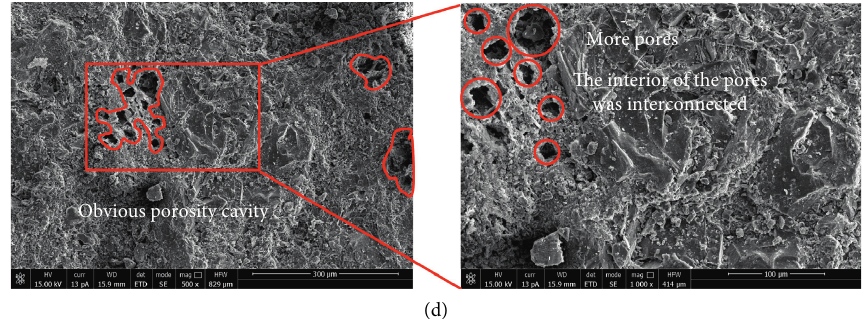
Figure 17: Evolution of the micro structure of the red sandstone with n : (a) n � 0, (b) n � 3, (c) n � 6, and (d) n �